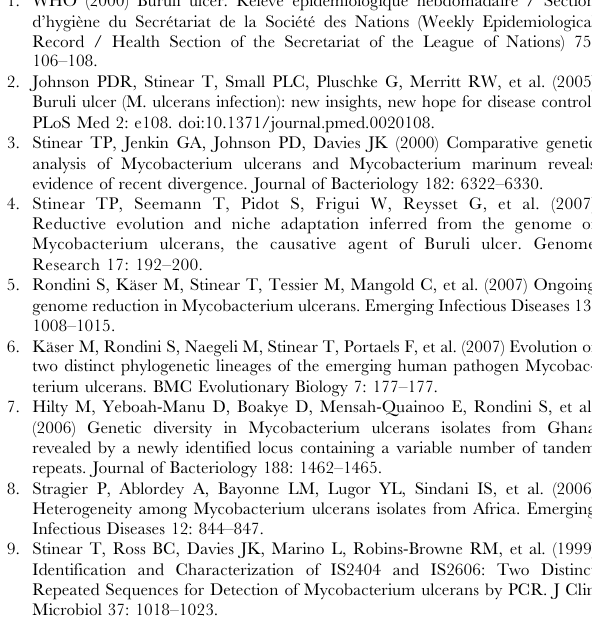
Table S2 SNPs identified by NimbleGen re-sequencing array in selected chromosomal and plasmid genes. SNPs confirmed by Solexa Genome Analyzer are indicated in the last column. Table S3 Primers used for PCR and sequencing of SNP harboring